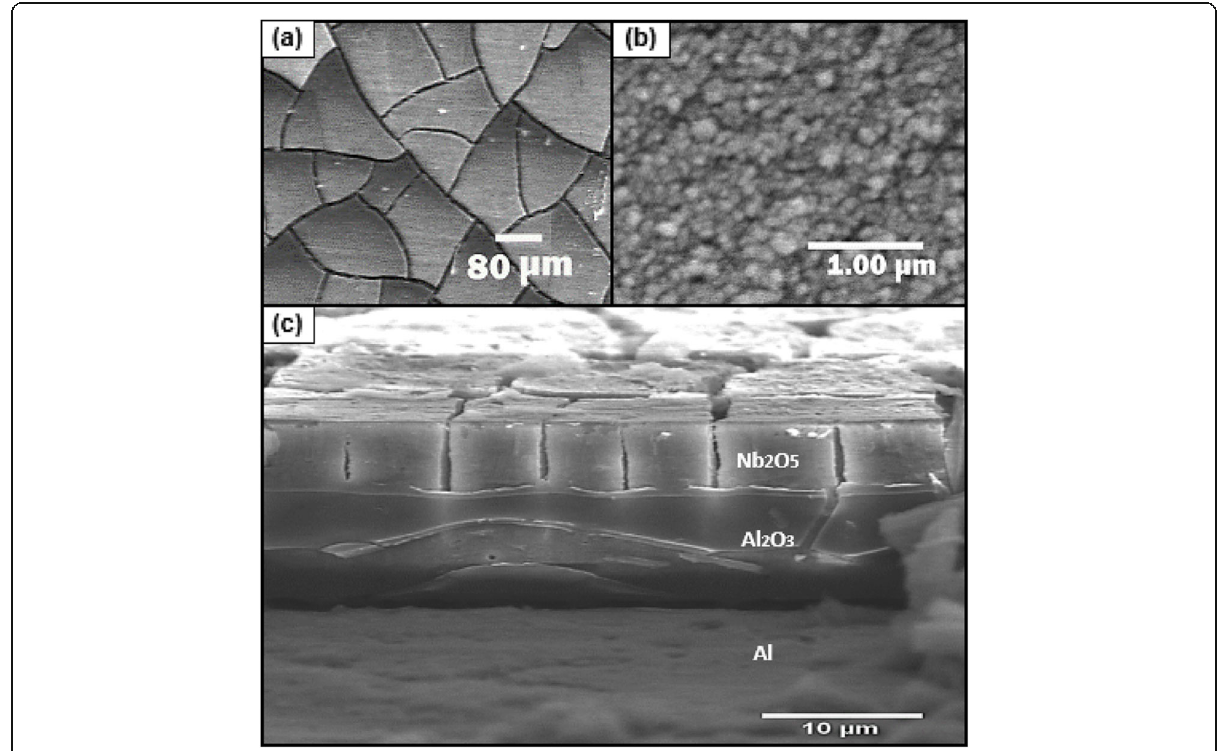
Fig. 3 SEM micrographs of Nb 2 O 5 /Al 2 O 3 /Al monolith. Ref.: ( a ), ( b ): Top view; ( c ): Vertical